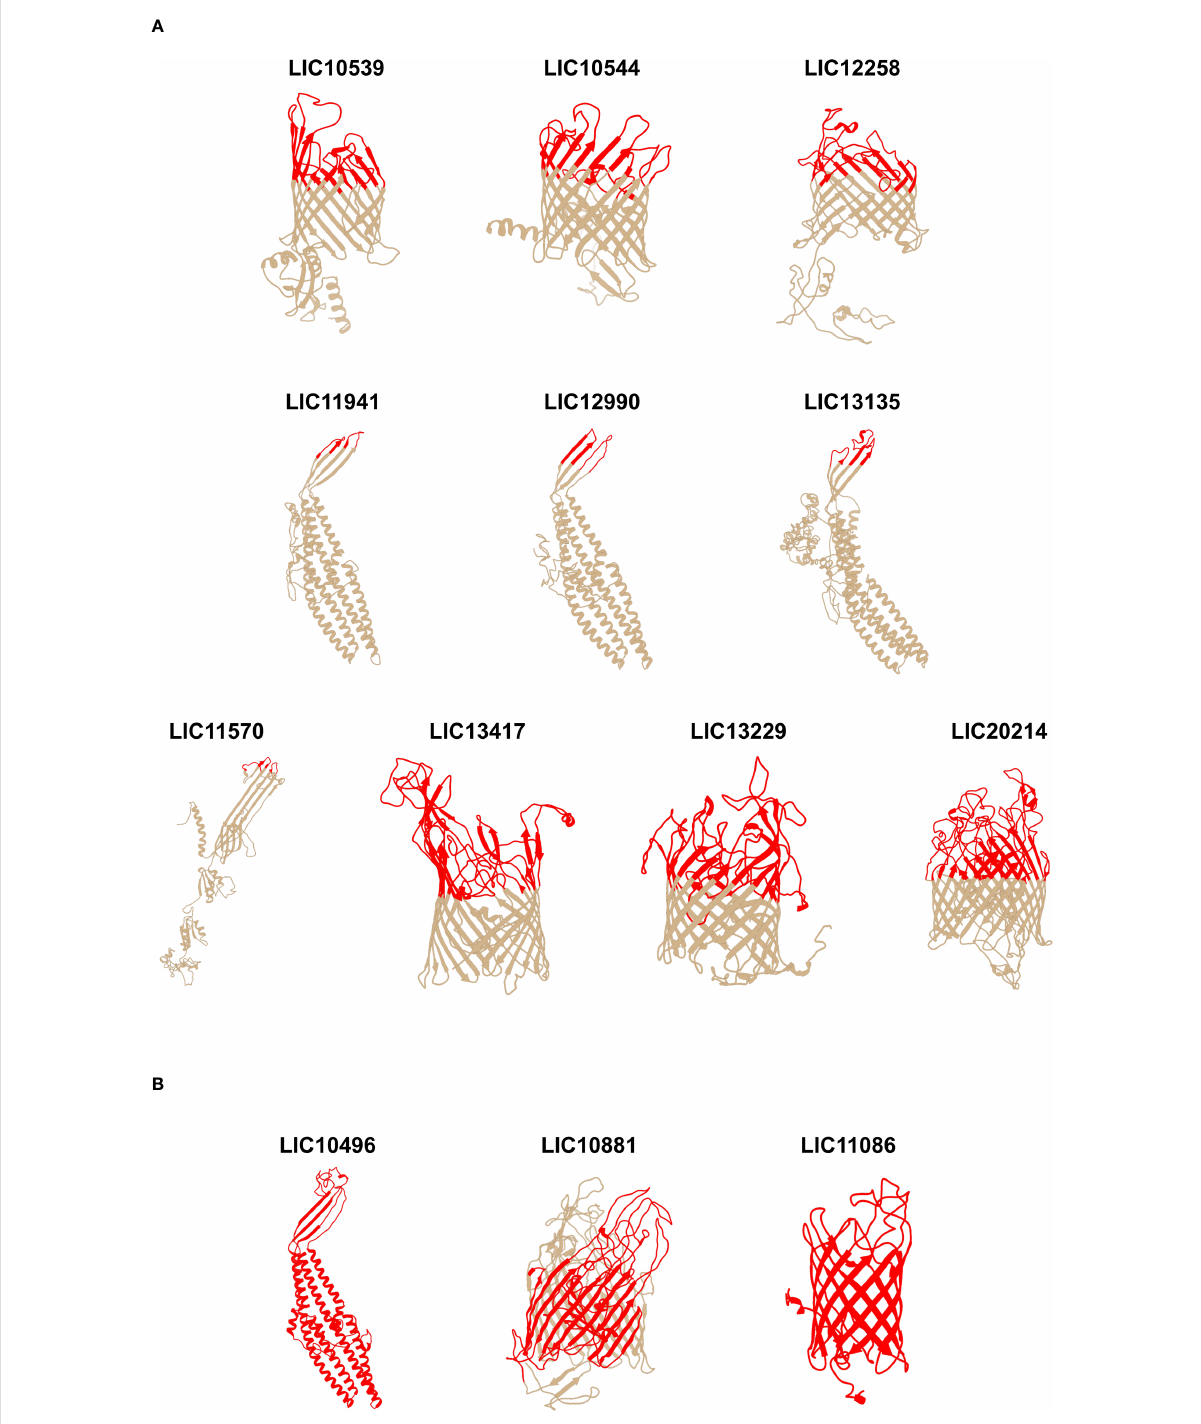
FIGURE 1 Predicted 3D models of the individual leptospiral b -barrel OMPs and mapping of the surface-exposed regions. The 3D models were determined using I-TASSER and the images were generated using UCSF Chimera software. (A) surface-exposed regions of 10 b b-OMPs (constructs do not contain transmembrane or periplasmic regions); (B) full-length protein constructs. The orientation of the b b-OMPs in the OM was derived from an interpretation of the best matching PDB structure. The upper, surface-exposed regions are shown in colour on the 3D models and these regions were used in the design of the recombinant proteins. The horizontal bars under the 3D models are a graphical representation of the composition of the